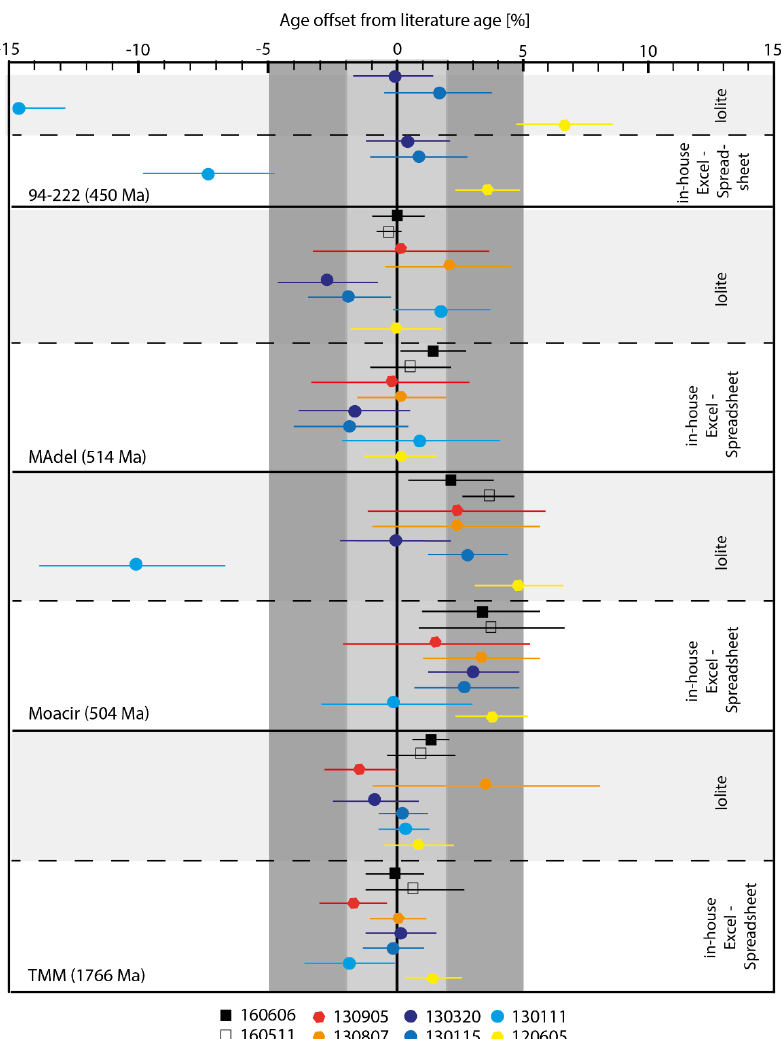
Figure 3. Comparison of the concordia ages calculated from the final ratios from the Iolite software and the in-house Excel worksheet, for monazite RM 94-222, Madel, Moacir and TMM. Monazite USGS 44049 was used as calibration RM and is therefore not displayed. Each spot/square represents the offset of the calculated concordia age from the literature value for a certain analytical session. The uncertainties are given in 2s. The light grey and dark grey bars represent the overall offset in per cent achieved in this study with 2% and 5%, respectively. Concordia data from the in-house Excel-spreadsheet is given in Table 3. All other data, the calculated concordia ages from the Iolite reduced data, the reduced data from the in-house spreadsheet and the Iolite software are provided in Table S2 and Table S3. It needs to be noted that the large discrepancy for monazite sample 94-222 in analytical session 130111 could be of analytical nature or due to data reduction. The exact reason for this offset, however, remains unknown.